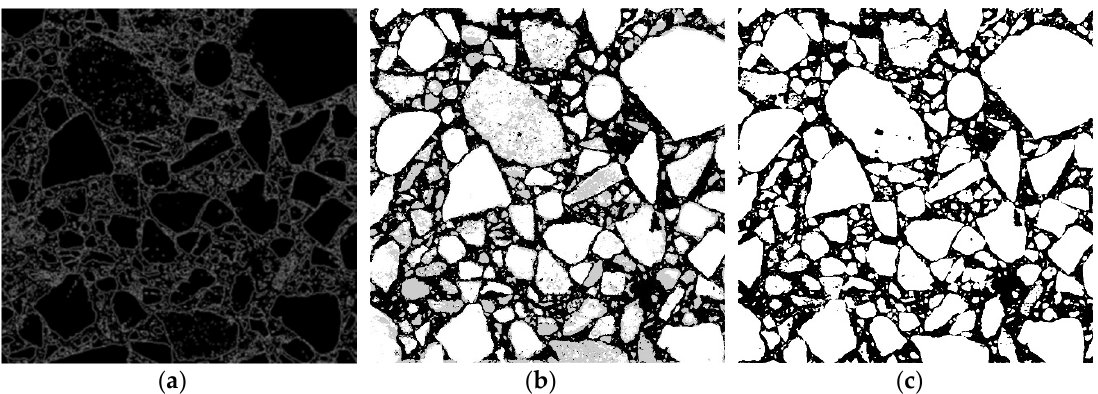
Figure 6. A series of segmentation process: ( a ) applying edge detection on the image of Figure 4b; ( b ) image map presenting different threshold values; ( c ) a binary image after threshold.